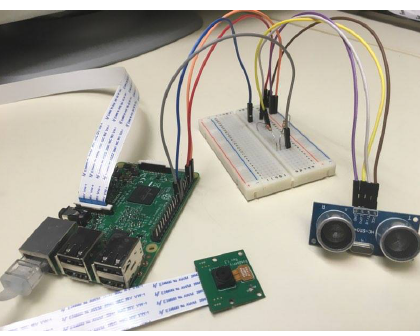
Figure 2. Jaco RoboticArm